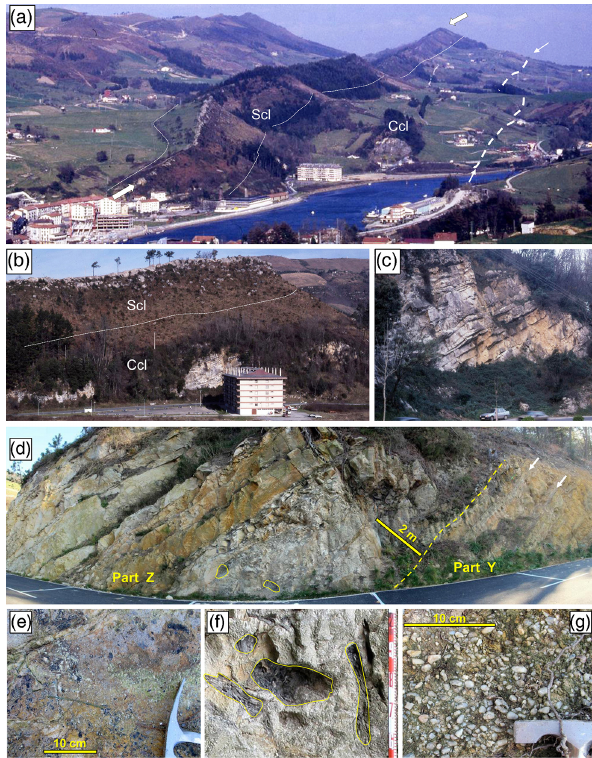
Figure 10. Panel (a) : general view of deep-sea channel deposits to the east of Orio (village at the bottom left corner of the image): the thick broken white line and small white arrows indicate the base of the deep-sea channel succession; the big white arrows point to the prominent ridge created by the PETM quartzarenites; Ccl and Scl, parts of the succession respectively dominated by calciclastic and siliciclastic deposits. Panels (b, c) : general view and close-up of Ccl deposits in quarries near the N-634 road; panel (d) : field view of the studied upper part of the Scl-dominated succession il- lustrating the different aspect of parts Y and Z; the white arrows in part Y designate thin clay interbeds. Panels (e–f) : close-ups of the quartzarenites of part Z, showing coal remains on the top surface of a bed, clay clasts and a pebbly accumulation (for additional features of part Z see Supplement Fig.